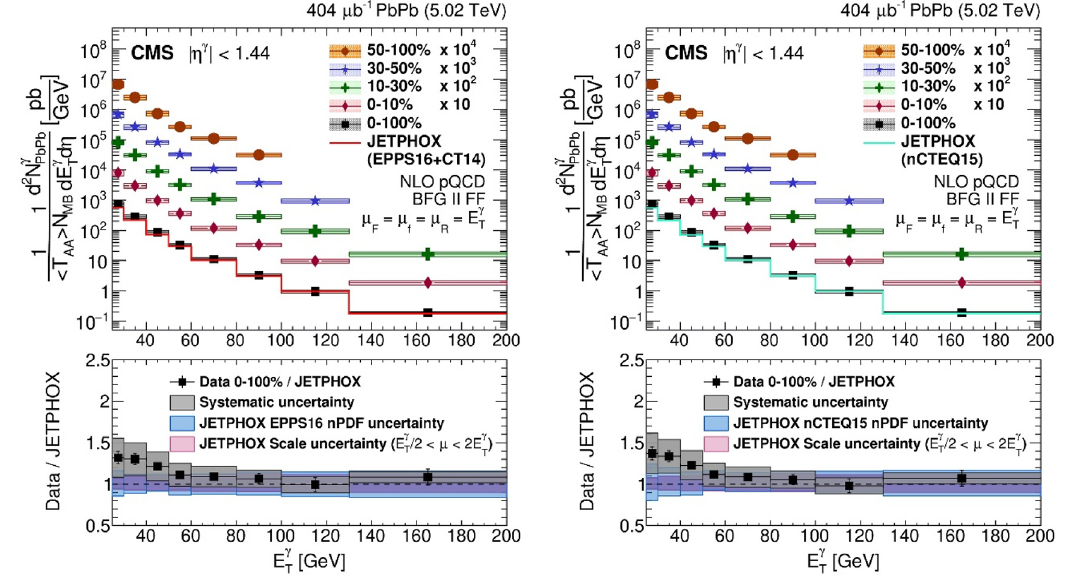
Figure 3 . Isolated photon spectra (upper) measured as a function of E g for 0{10%, 10{30%, 30{ T 50%, 50{100%, and 0{100% PbPb collisions (scaled by T ) at 5.02 TeV. The spectra are scaled AA by the factors shown in the legend for clarity. The symbols are placed at the center of the bin. The vertical bars associated with symbols indicate the statistical uncertainties and the horizontal bars re(cid:13)ect the bin width. The statistical uncertainties are smaller than the symbols. The total systematic uncertainties are shown as boxes in each E g bin. The spectra in the 0{100% centrality bin T are compared to the NLO jetphox calculations with EPPS16+CT14 nPDFs (left) and nCTEQ15 nPDFs (right). The ratio of the data in the 0{100% centrality class to jetphox is shown in the lower panels. The gray boxes indicate the total systematic uncertainties of the data. The blue and red hatched boxes correspond to the jetphox PDF and scale uncertainties,